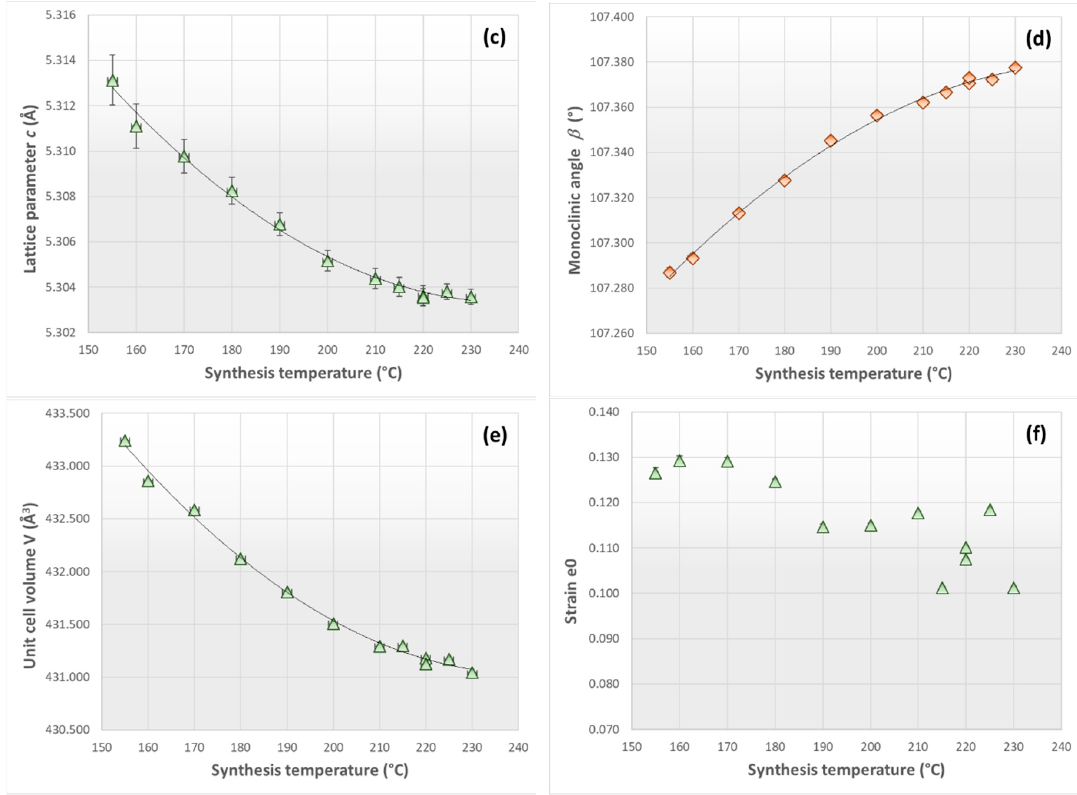
Figure A3. Variation of unit cell parameters ( a – e ) for the aegirines, synthesized at different temperatures between 155 °C and 230 °C with a run duration of 24 h; ( f ) is the dimension-less microstrain.